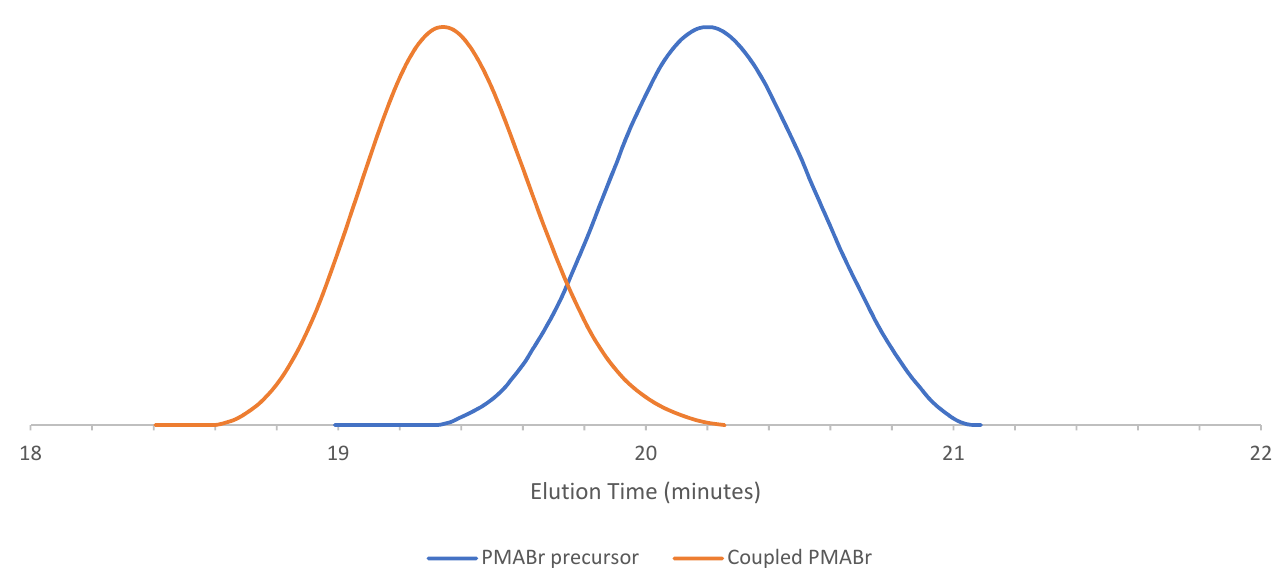
Figure 2. GPC traces of PMABr precursor (blue) and RTA-ATRC product (orange) under universal conditions using MNP as the radical trap-assist. Traces correspond to Table 1, Trial 11. Table 2. Characteristics of PMMABr precursors and results of their RTA-ATRC